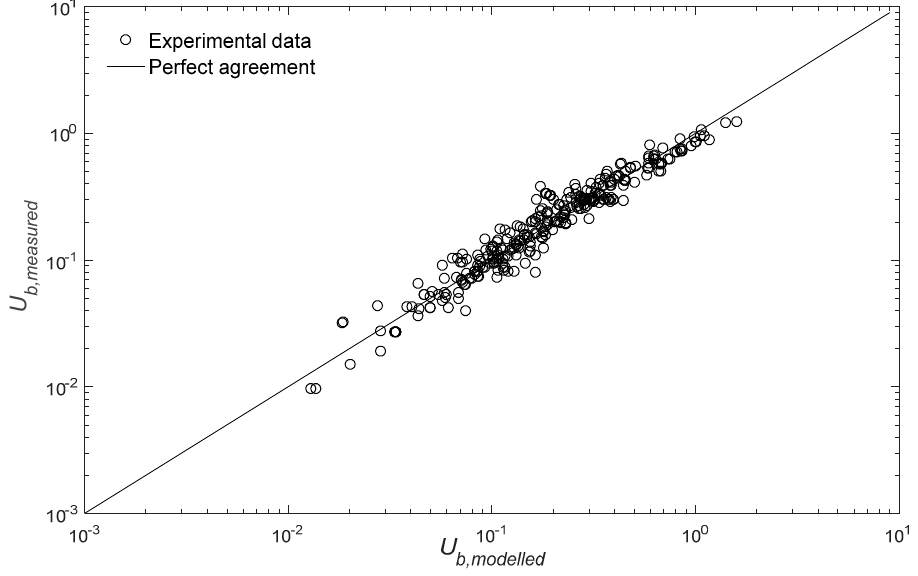
Figure 8. Comparison between the measured and modeled bulk velocity U b ( MSE = 0.0041).